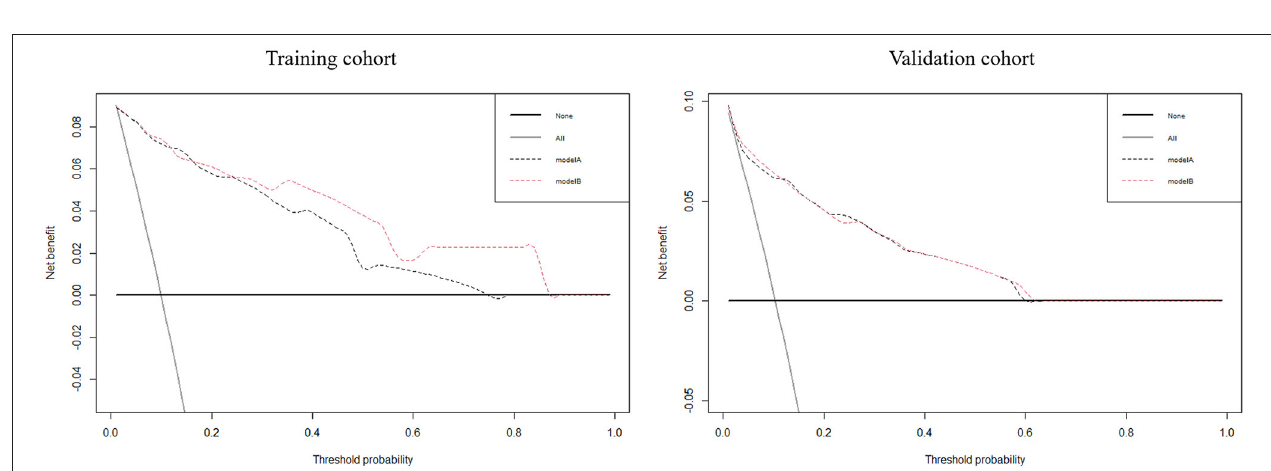
= 0.06, 95%CI = − 0.01–0.13, p = 0.10; IDI = 0.07, 95% CI = 0.05–0.08, p <